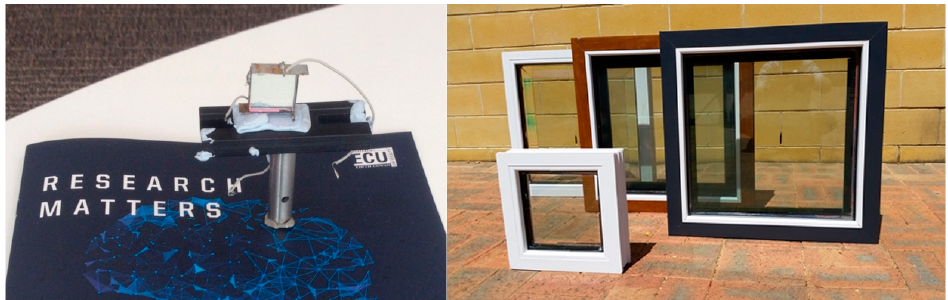
Figure 6. Solar window prototypes developed at Edith Cowan University (ECU between and demonstration experiments aimed at the visualisation of